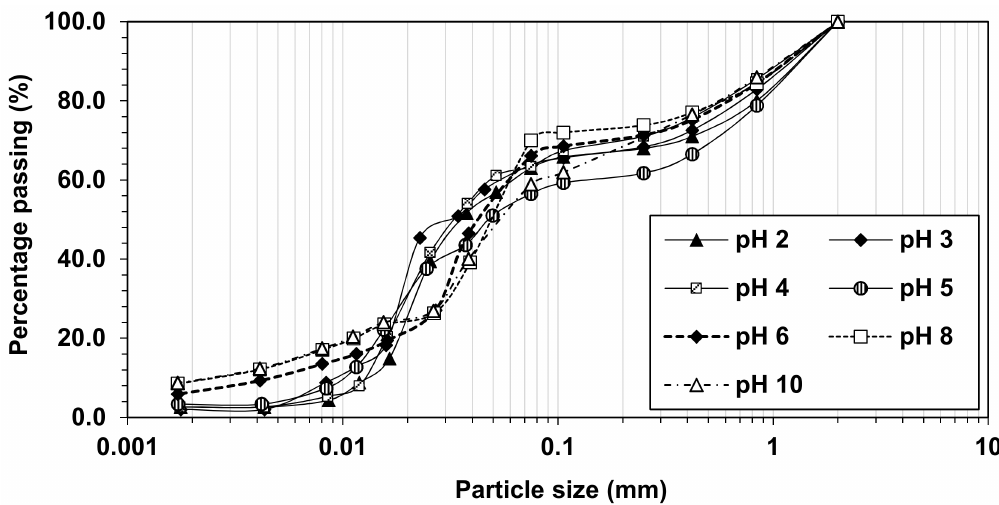
Figure 4. Particle size distribution at different pH values ranging from 2.0 to 10.0.